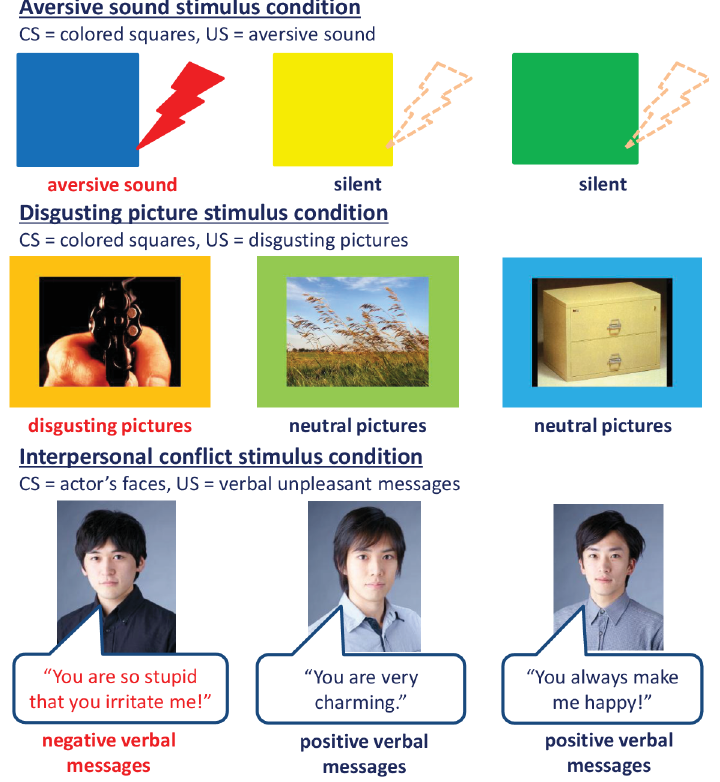
Fig 1. Conditioned stimulus and unconditioned stimulus used in the three types of stimulus paradigms. Abbreviations: CS, conditioned stimulus; US, unconditioned